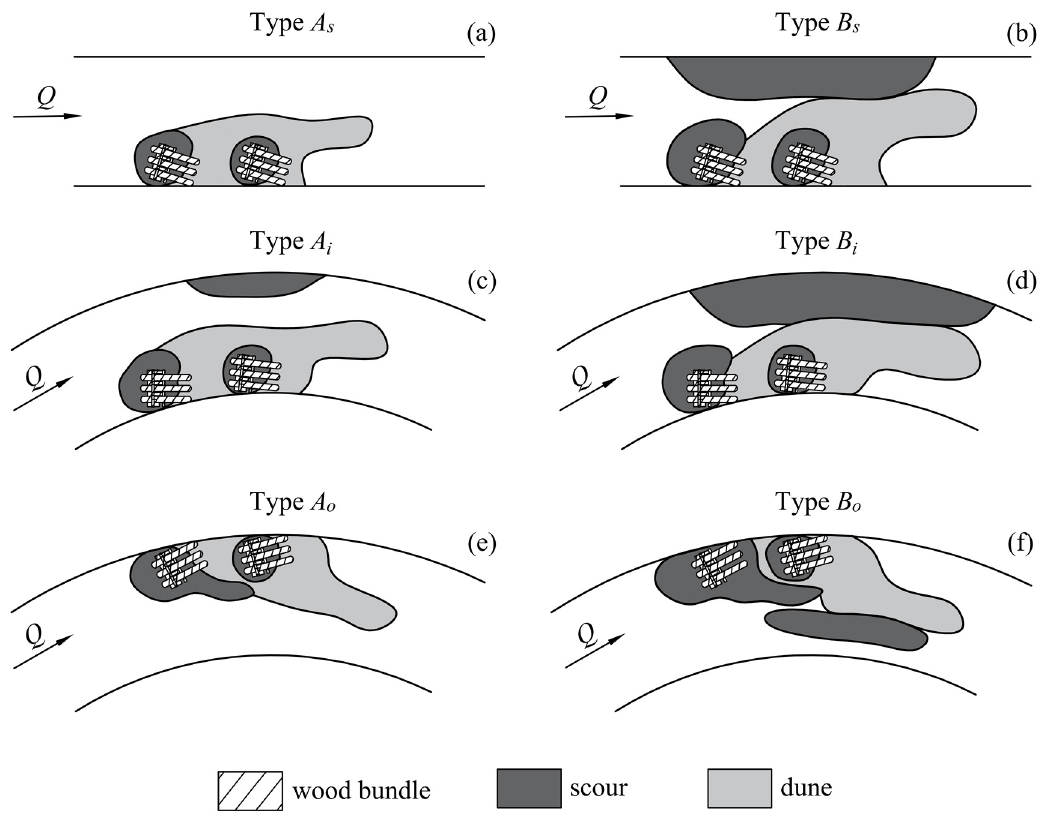
Figure 9. Scour morphology types for wood bundles in straight and curved channels: Types ( a ) A s and ( b ) B s for the straight channel, i.e., ( B − b )/ R = 0; Types ( c ) A i and ( d ) B i for the curved channel inner bank position, i.e., ( B - b )/ R = 0.213; Types ( e ) A o and ( f ) B o for the curved channel outer bank position, i.e., ( B − b )/ R = 0.038.